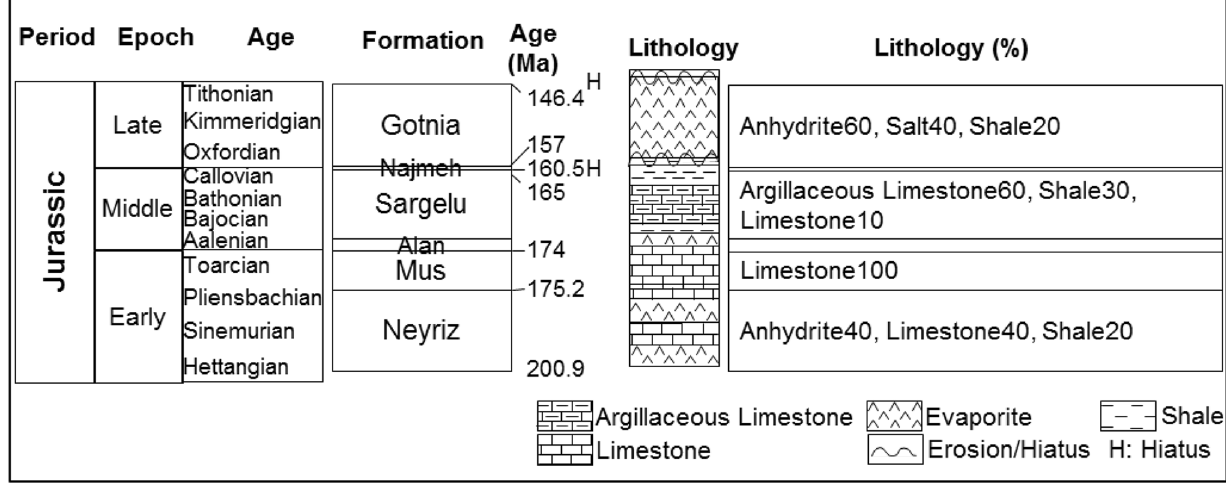
Fig. 2 Stratigraphic column of the Jurassic successions in the Darquain field (data from unpublished geological well completion report of well Darquain